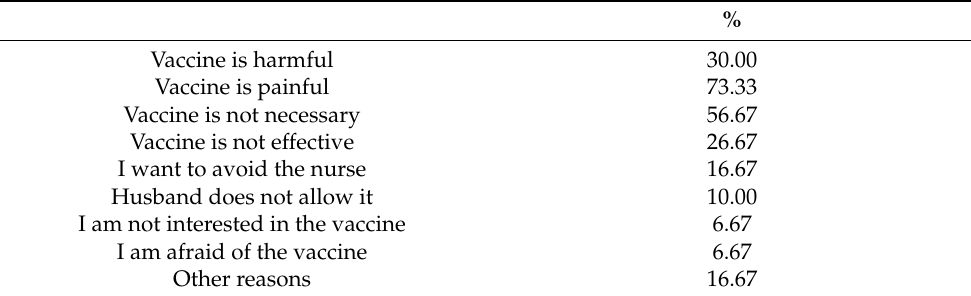
Table 5. Reasons for not receiving